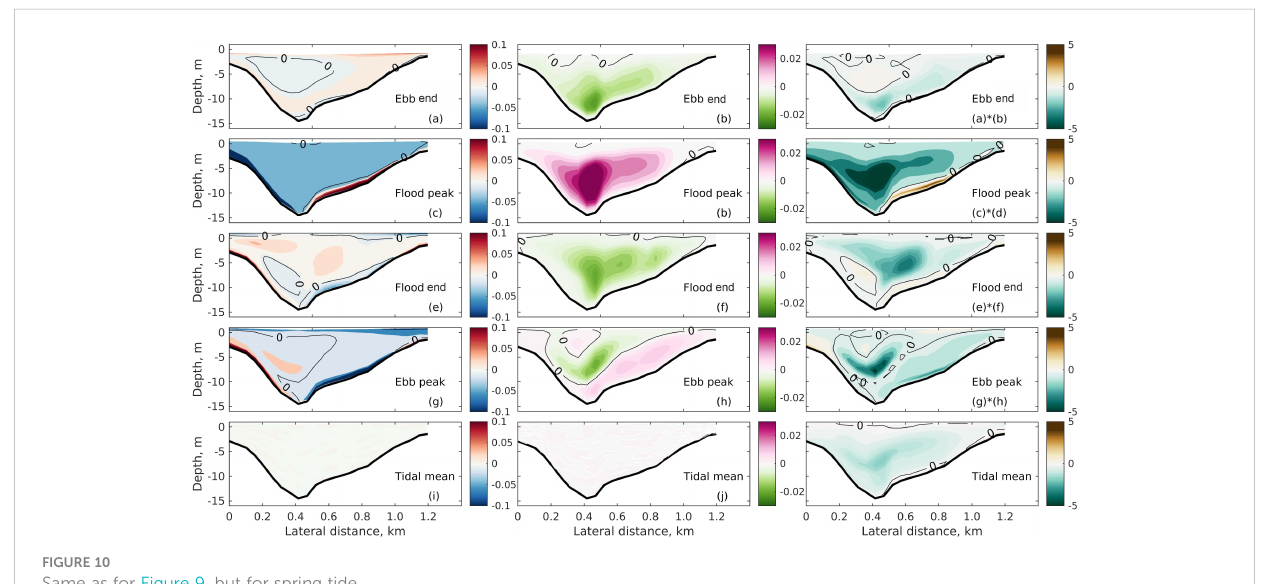
FIGURE 10 Same as for Figure 9, but for spring